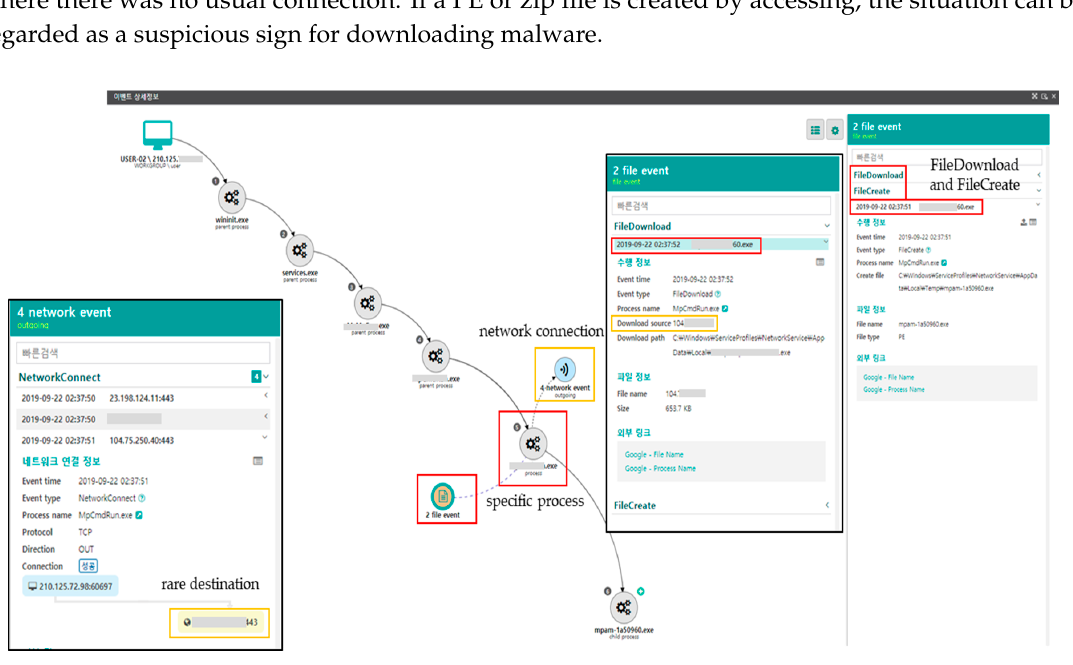
Figure A2. Attack Profile C & C access suspicious scenario due to malware infection. References 1.